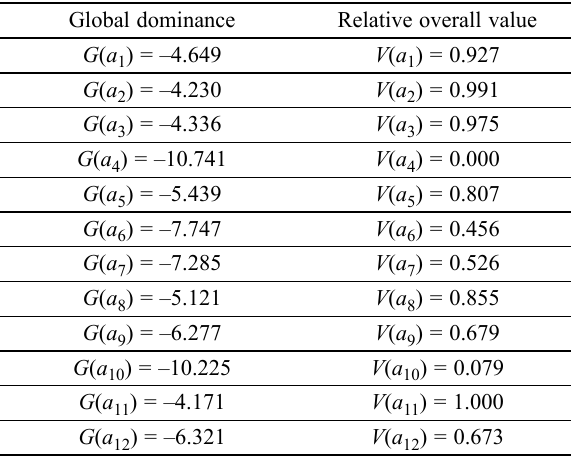
Table 8. Global dominance and relative overall value Global